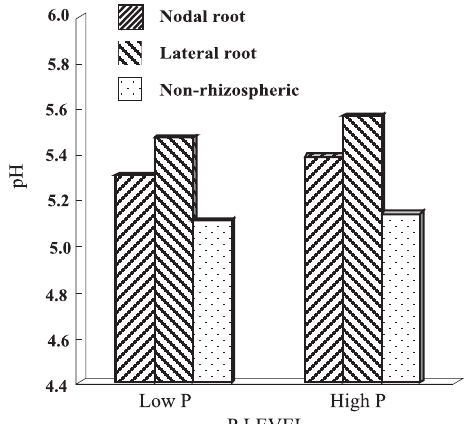
Figure 4. Mean pH values in rhizospheric and non- rhizospheric soil of nodal and lateral roots of maize genotypes grown at low and high P